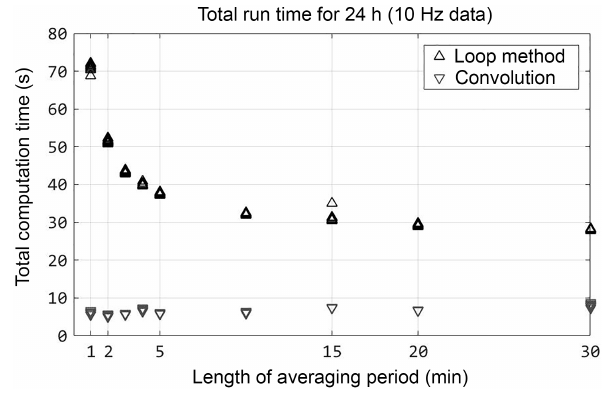
Figure 5. Ten iterations of the structure function calculations using a range of averaging